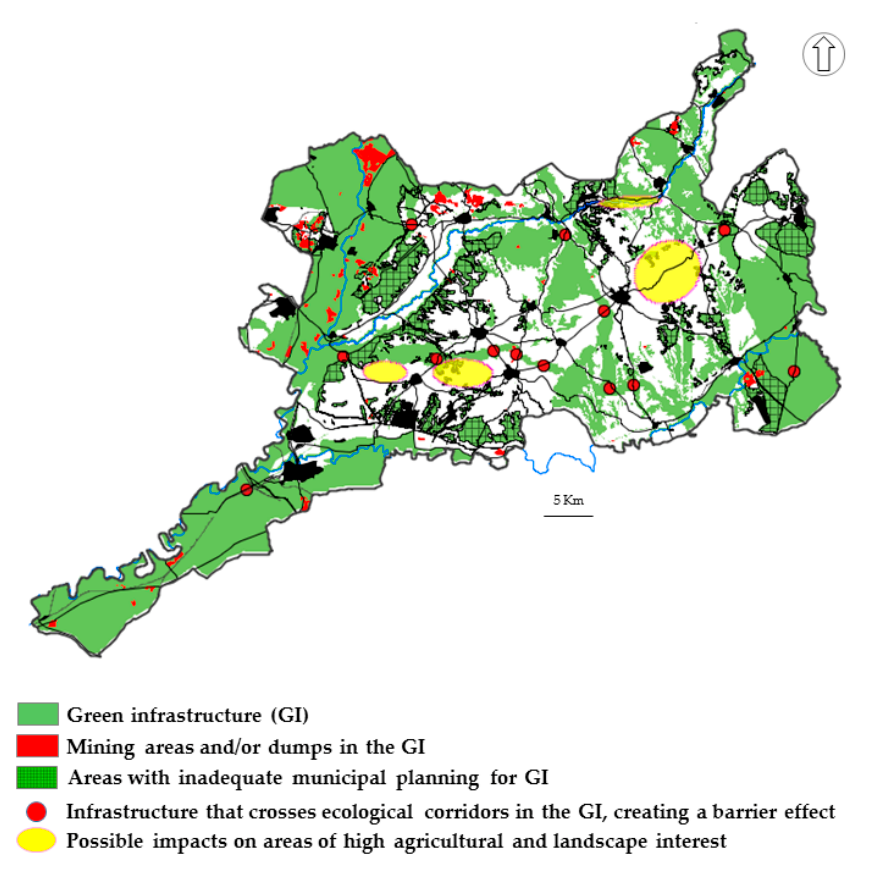
Figure 9 . Territorial conflicts that affect the territorial connectivity and the delivery of ecosystem services of the matrix that makes up the GI.